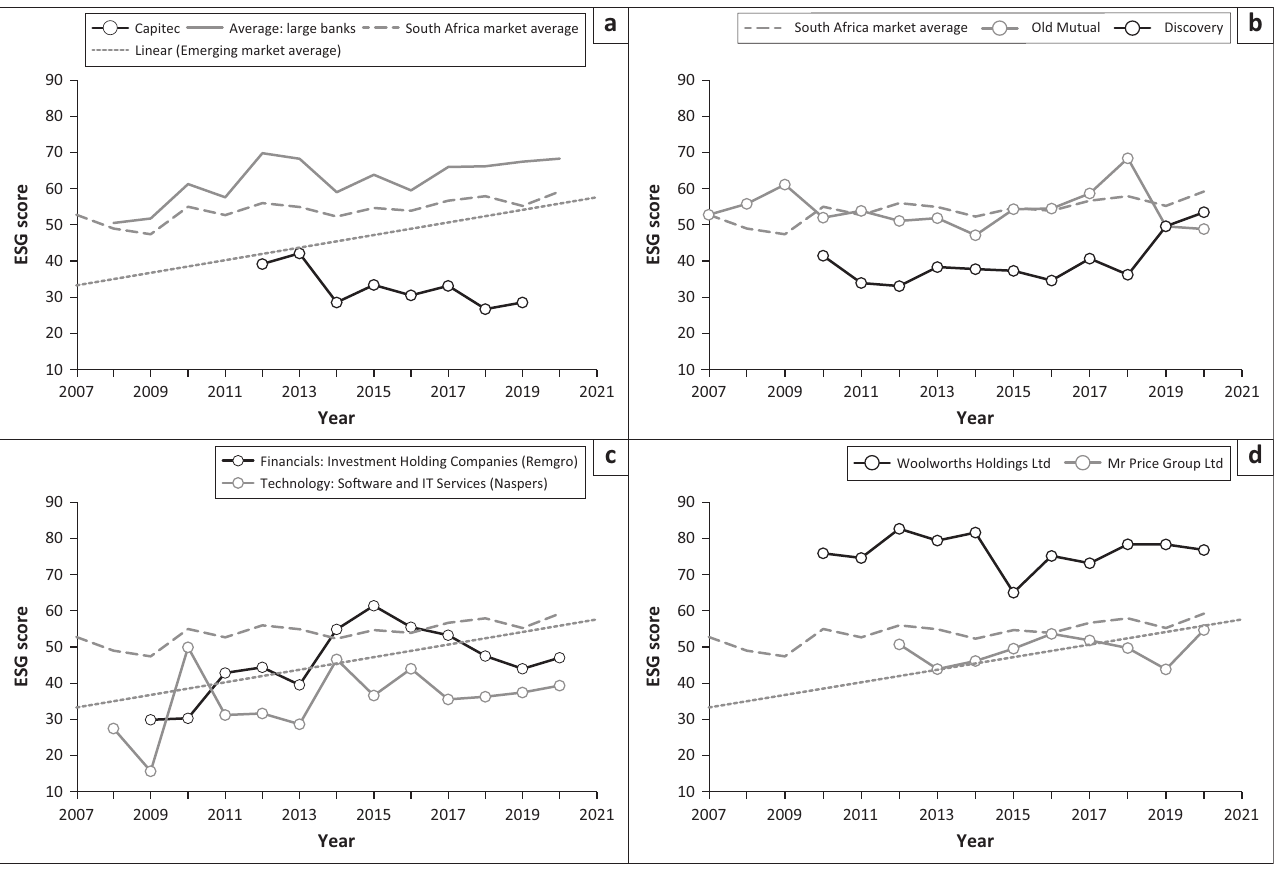
Source : Reuters Refinitiv and authors’ calculations. ESG, environmental, social and governance. FIGURE 3: Environmental, social and governance scores (and relevant trends) for representative South African stocks selected from the (a) banking, (b) insurances, (c) technology and (d) consumer cyclicals sectors over 2007–2020. Vertical scales are identical for comparison.